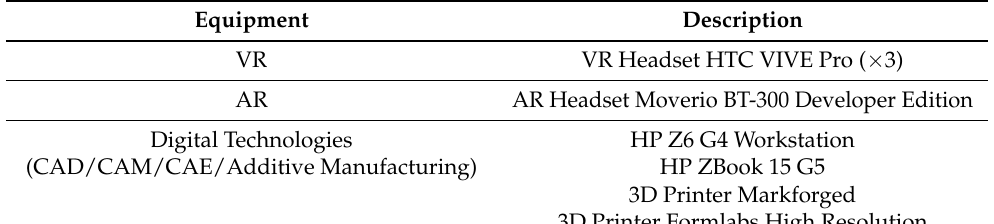
Figure 2. Distribution of work spaces, Ethernet connections, and VR sensors in the VR/AR laboratory at UPAEP: room A . Table 1. Equipment and resources in the VR/AR laboratory at UPAEP: room A